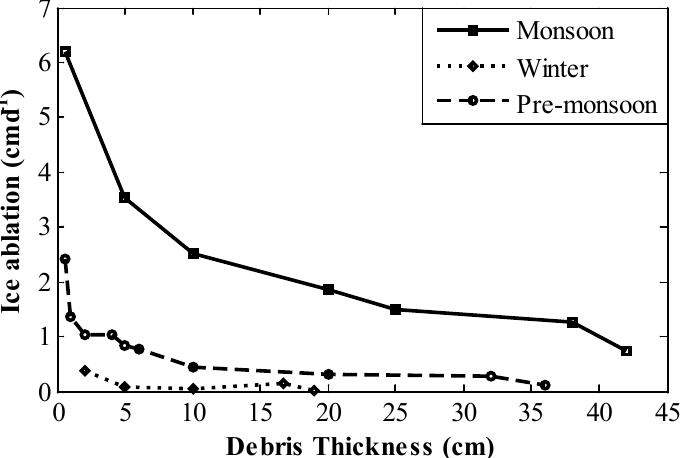
Fig. 2 Daily ablation rate during the monsoon (line with rectangles), winter (dotted line with rhombi) and pre-monsoon season (dashed line with